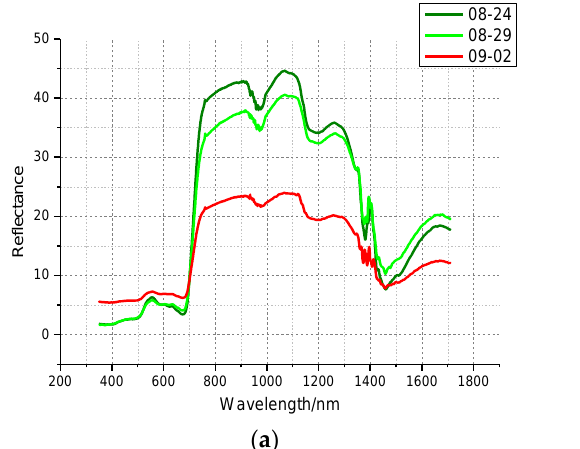
Figure 14. ( a ) The field spectral of cotton measured in Xinjiang. ( b ) The white bolls under satellite view in Xinjiang at 2014-10-16 from google earth.